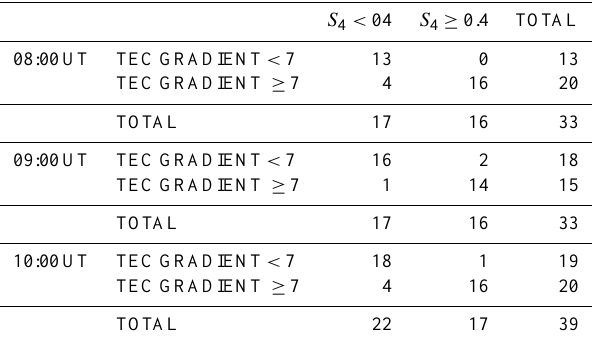
Table 5. Chi-square ( χ 2 ) values for the above stations during